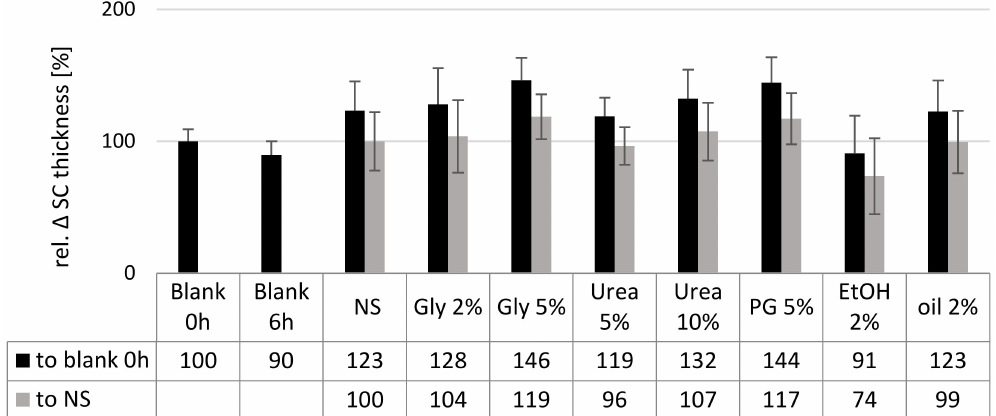
Figure 4. Influence of excipients on the stratum corneum thickness determined by digital image analysis. Black columns: relative thickness of SC when compared to non-treated, fresh skin. Grey columns: relative thickness of SC when compared to the SC of the skin treated with aqueous curcumin